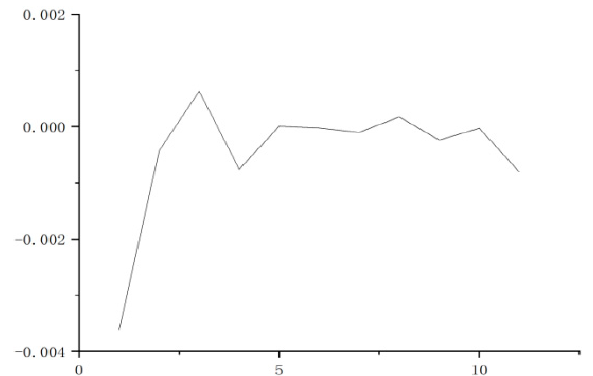
Figure 8. Mean value of first-order difference sequence.